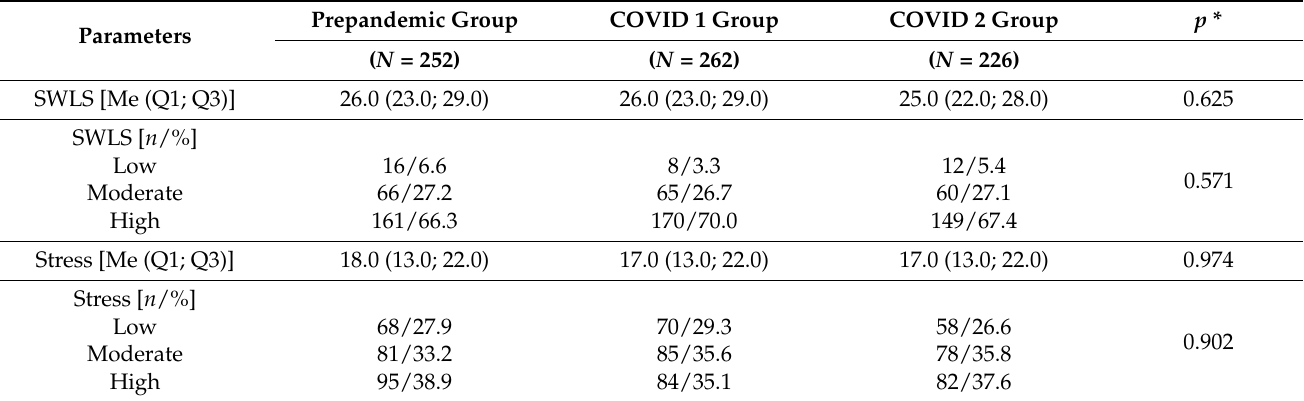
Table 4. Levels of Life Satisfaction and Perceived Stress of